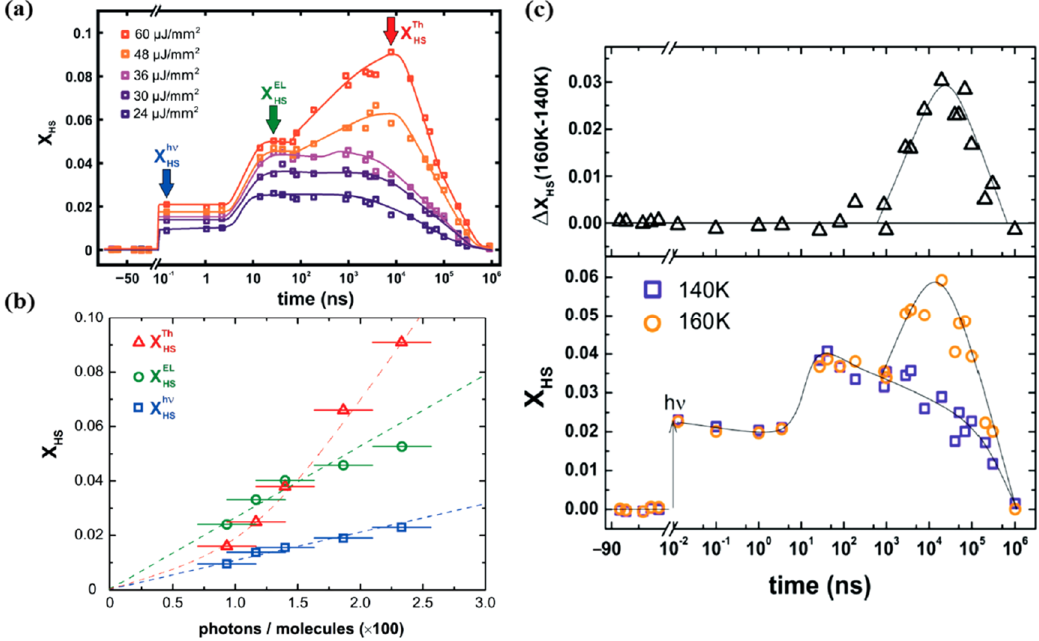
Figure 8. ( a ) The femtosecond laser excitation of low spin [Fe(Phen) 2 (NCS) 2 ] to the high spin state at 140 K for different excitation energy densities. The photoinduced, elastic, and thermal steps to the high spin state are denoted as “hν”, “El”, and “Th” respectively. ( b ) The fraction of high spin state occupancy, X HS , with respect to the number of incident photons per 100 molecules. ( c ) The bottom panel shows the comparison of the photo-response, for the same excitation energy density of 30 µJ mm −2 at 140 K and 160 K. The top panel shows the difference between the high spin fraction between 140 K and 160 K. Reproduced with permission from Ref. [66]. Copyright (2016) the Royal Society of Chemistry.